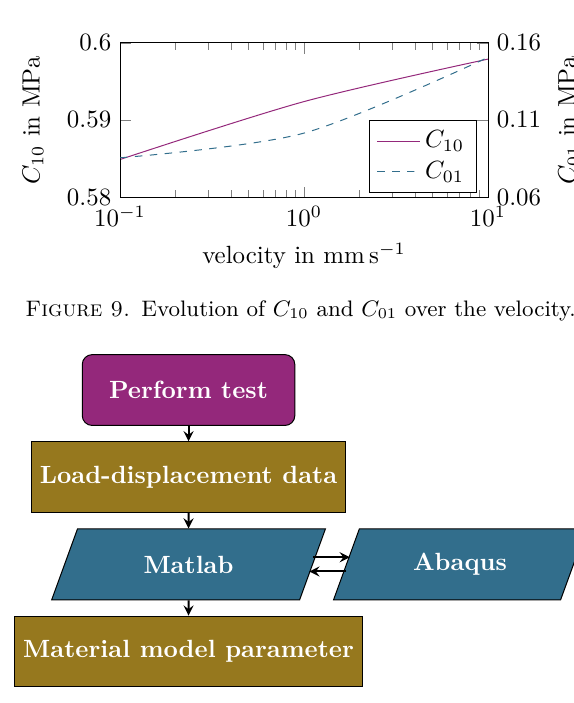
Figure 10. Workflow for the finite element updating